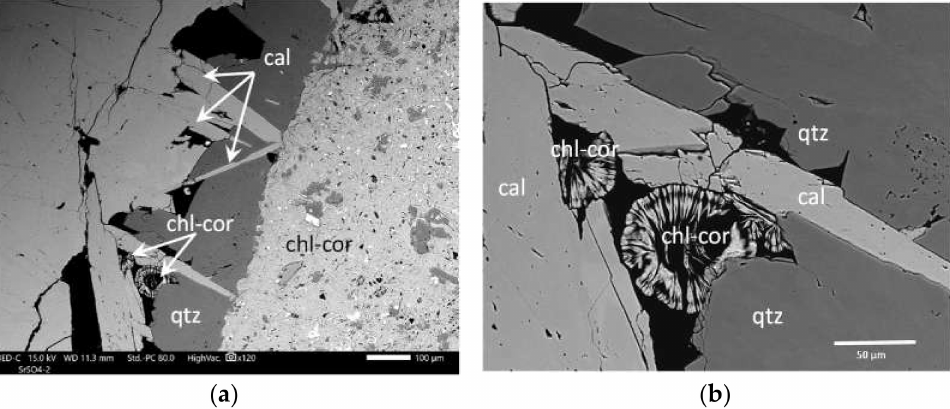
Figure 10. SEM petrographic observations in back-scattered electron mode. Co-precipitation of chlorite, corrensite ( ± Chl/Cor), platy calcite and quartz. Basaltic lava at 426 m. ( a ) General view, and ( b ) zoomed-in viewing showing mutual stopping between quartz, calcite and trioctahedral